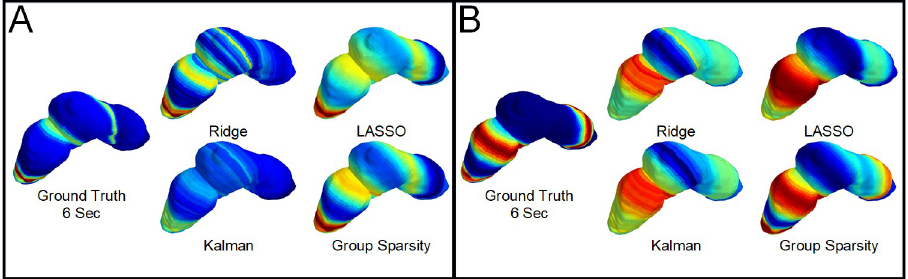
Fig 8. Time snapshot of the inverse results mapped back to geometry. A) Normal simulation at the 10 dB SNR level at the 6 Second time point. B) Abnormal simulation at the 10 dB SNR level and the 6 second time